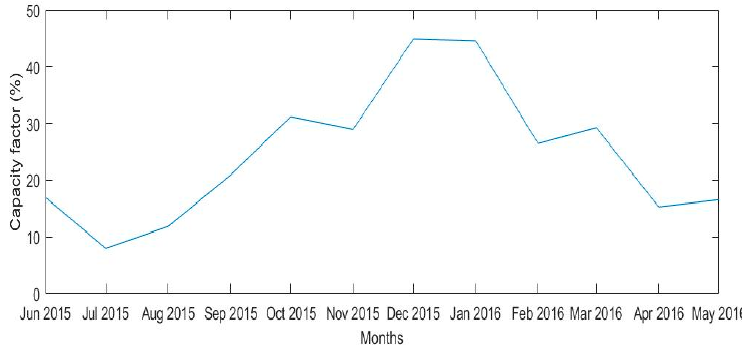
Figure 15. The monthly capacity factor of the wind-farm.